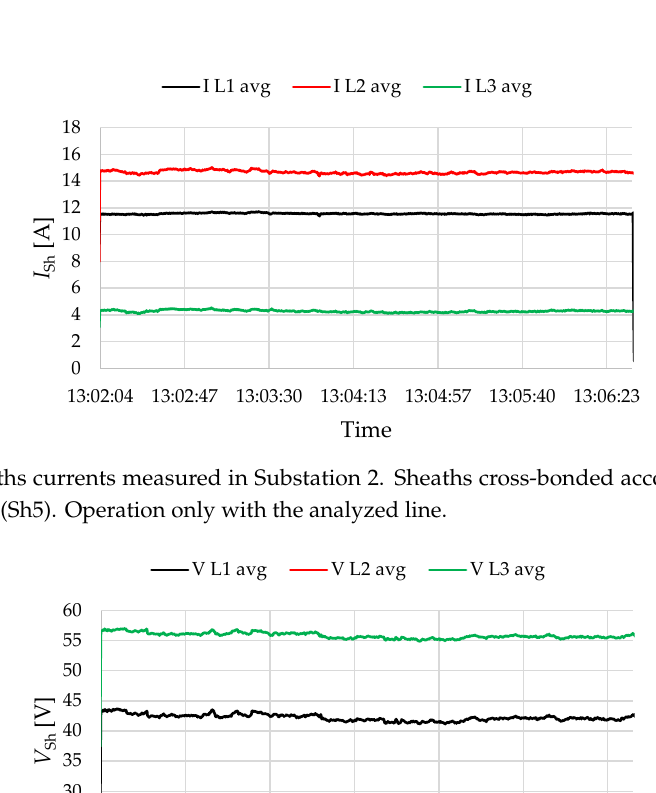
Figure 18. Sheaths voltages measured in Substation 2. Sheaths cross-bonded according to: L1 → L3, L2 → L1, L3 → L2 (Sh4). Operation only with the analyzed line.